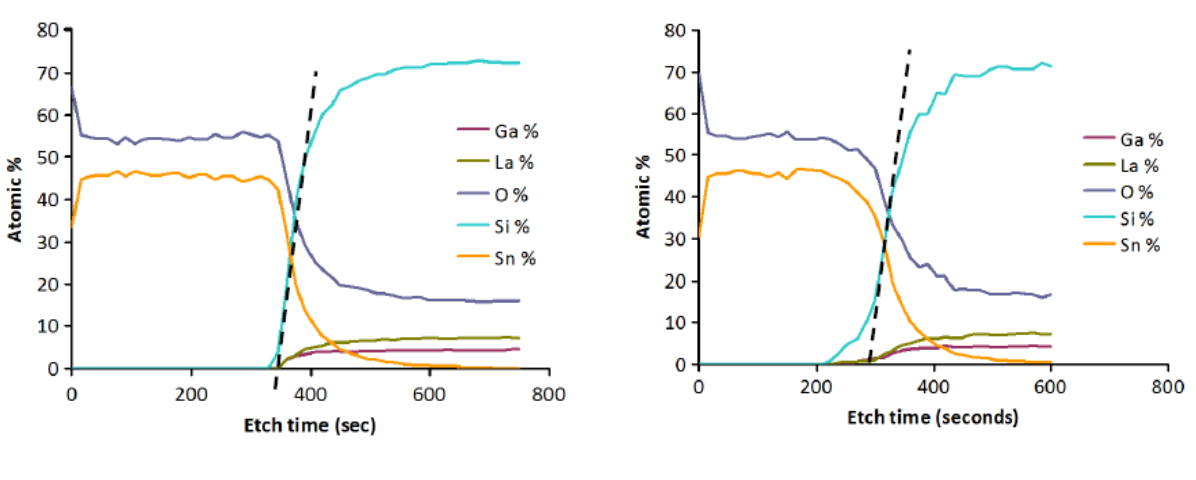
Figure 15. XPS depth profiles ( Left ) as-deposited and ( Right ) after 700 °C one hour anneal, and a sequence of gas sensing